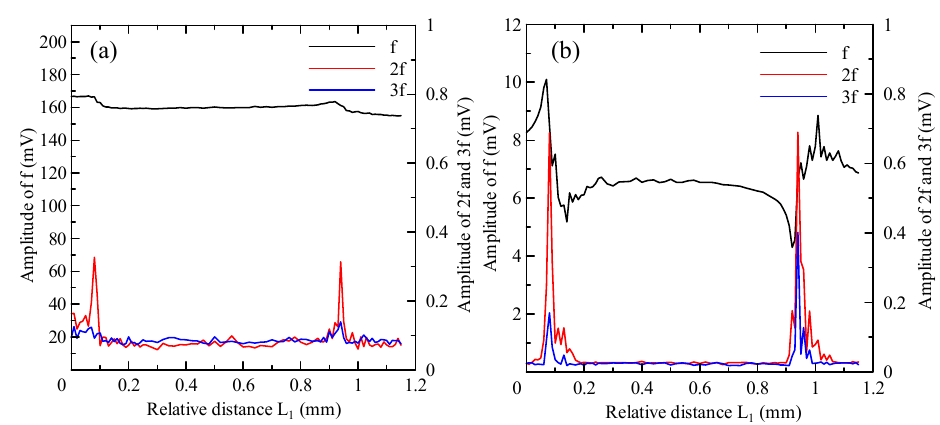
Fig.5 Output amplitude of (a) Receiver 1 and (b) Receiver 2 for 101 kPa,